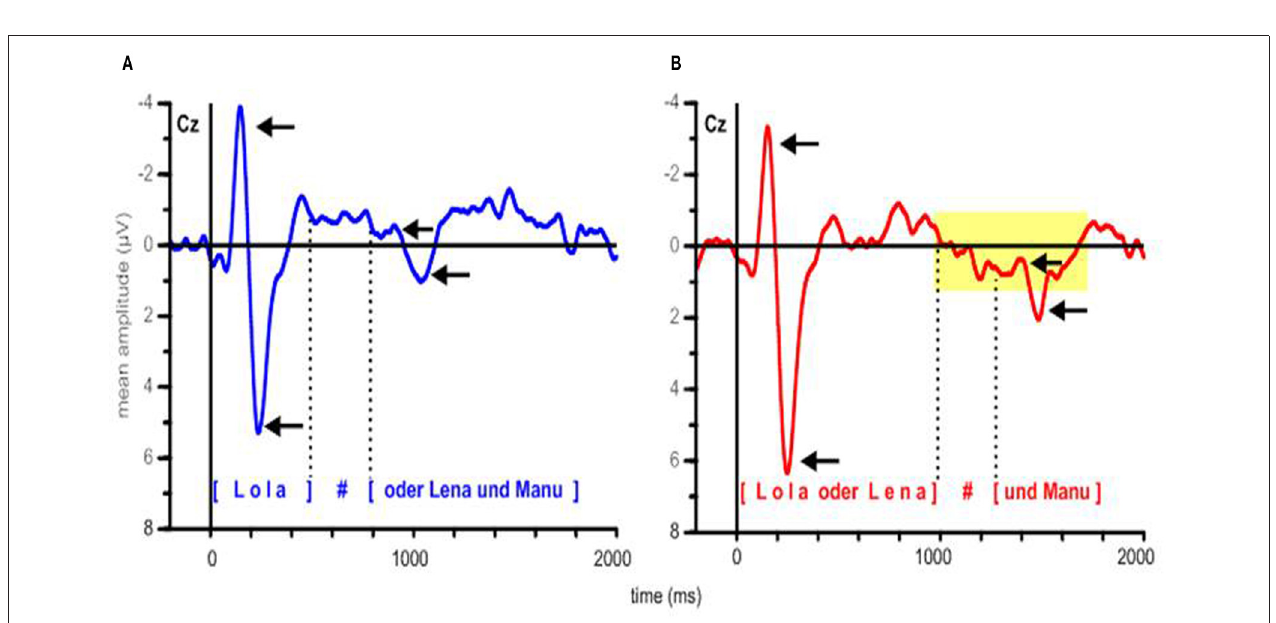
FIGURE 5 | Grand average ERPs at electrode Cz, depicted separately for (A) the EARLY and (B) the LATE condition. Arrows indicate the N100 and P200 components at the stimulus onset and at the onset of the second part of the utterance. Dotted lines